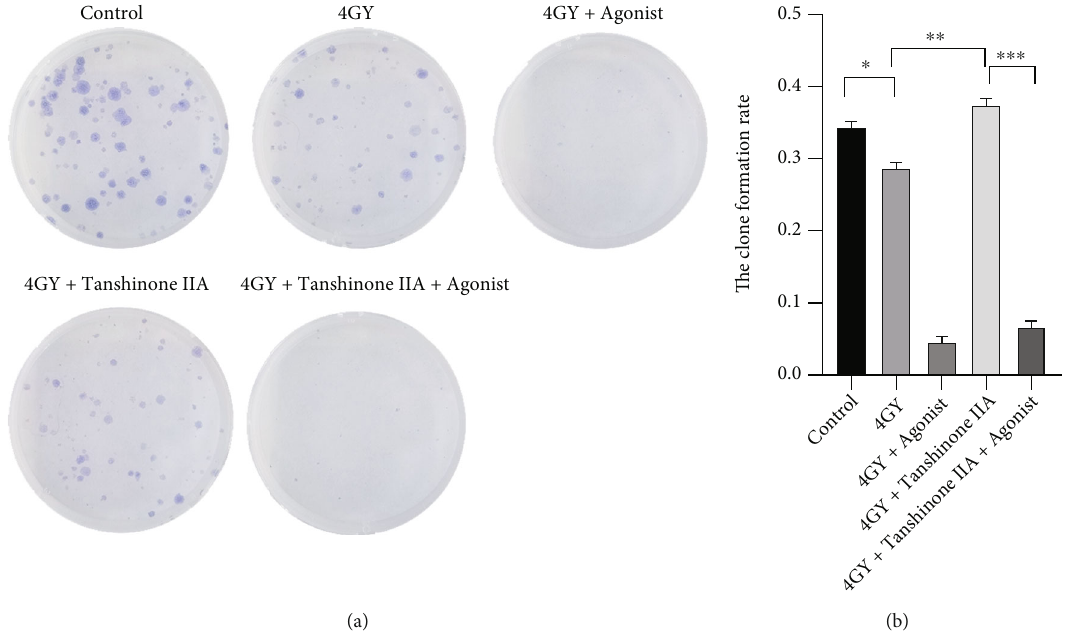
Figure 1: E ff ects of radiation and tanshinone IIA on cardiomyocyte proliferation. (a) The results of clonogenic assay suggested that radiation could inhibit normal cardiomyocyte growth, while tanshinone IIA could eliminate this inhibition to some extent. (b) The results of cell cloning experiments were expressed as the number of colonies of the cells. ∗∗∗ P < 0 : 001 , ∗∗ P < 0 : 01 , and ∗ P < 0 : 05